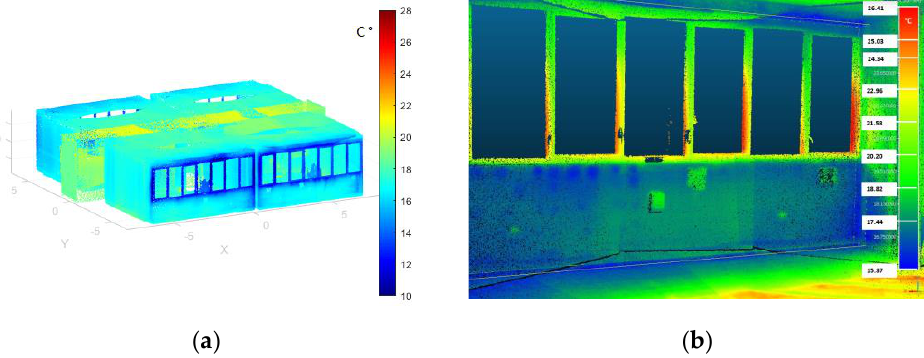
Figure 2. As-is T-BIM thermal point-cloud: ( a ) perspective of the block of five thermal zones; ( b ) indoor view of a thermal zone.